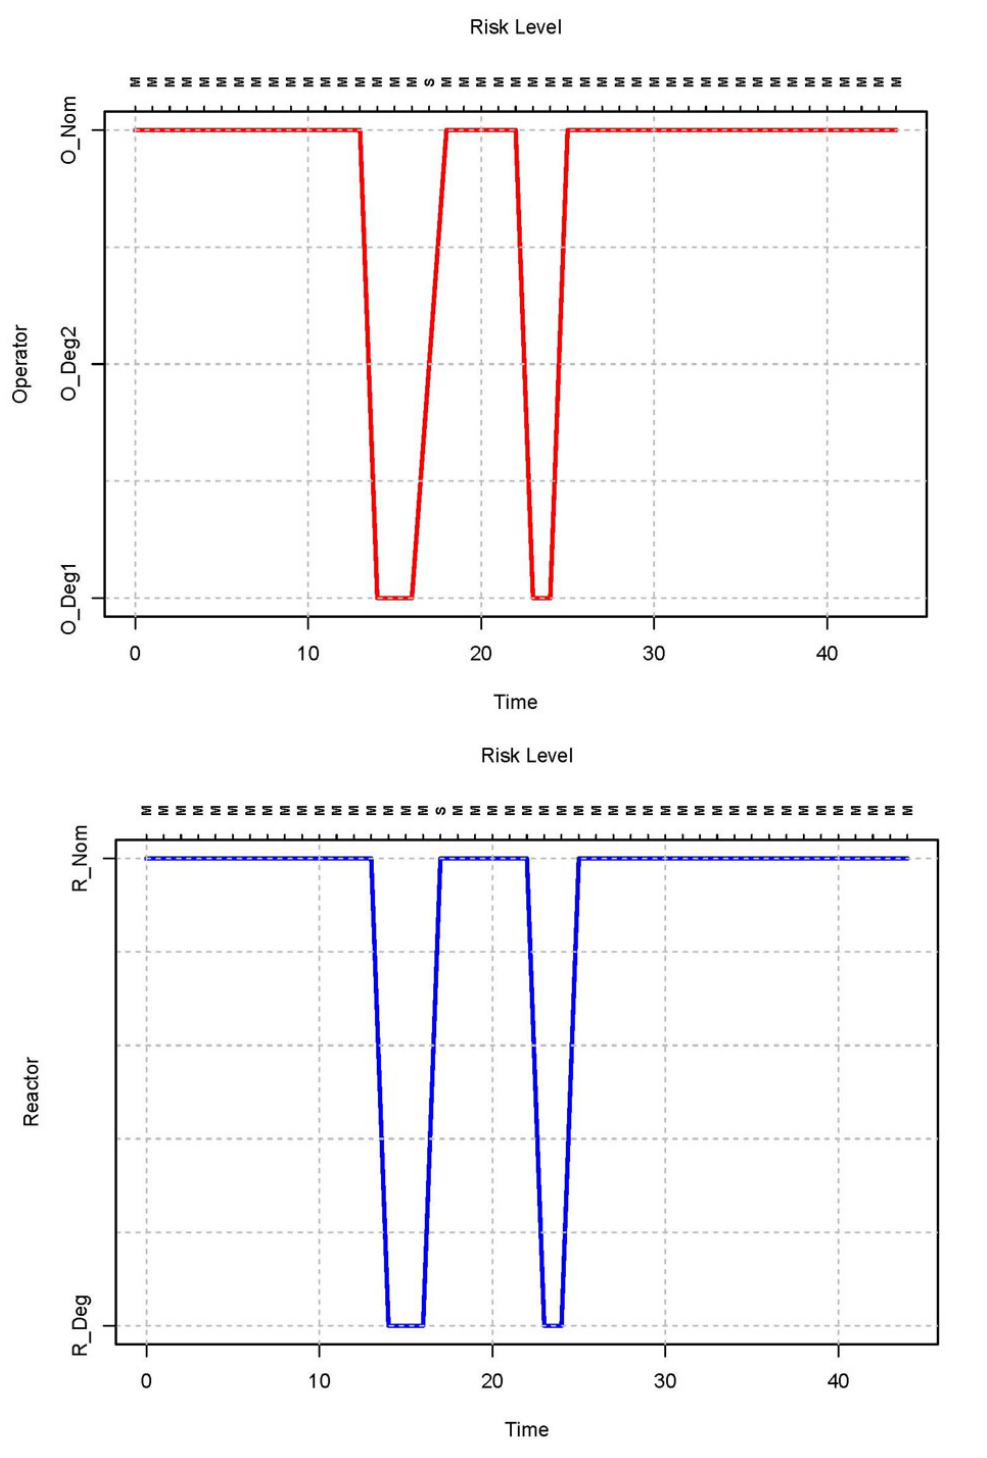
Figure 15. Agent’s behavioral modes with the related Risk Level during simulation